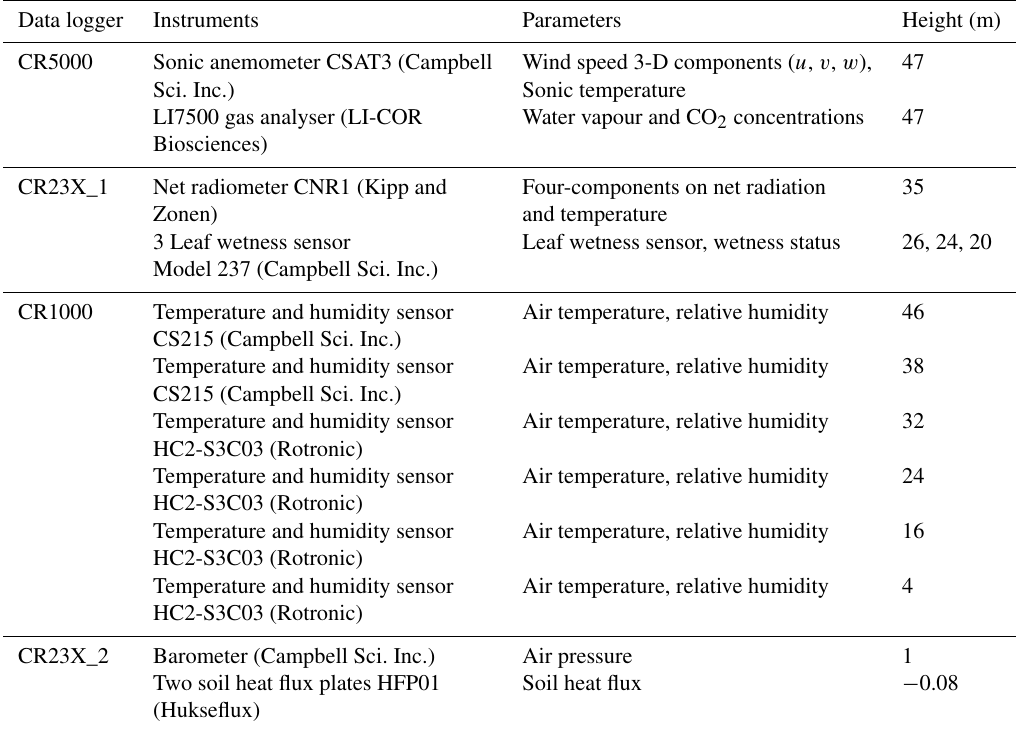
Table 1. Main micro-meteorological instruments installed on the Speulderbos flux tower. Data